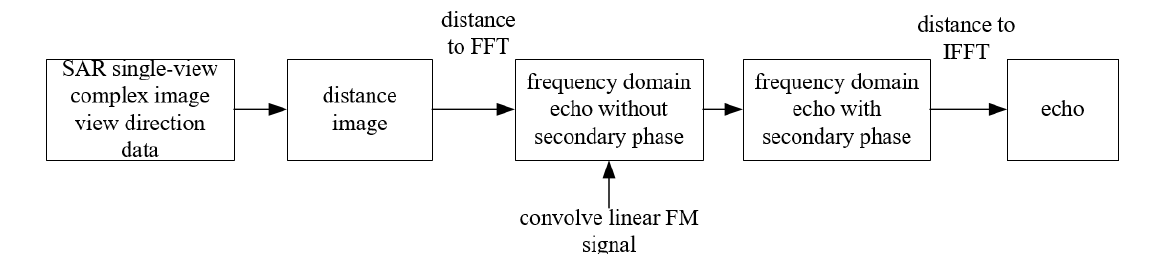
Figure 9. The flowchart from image to